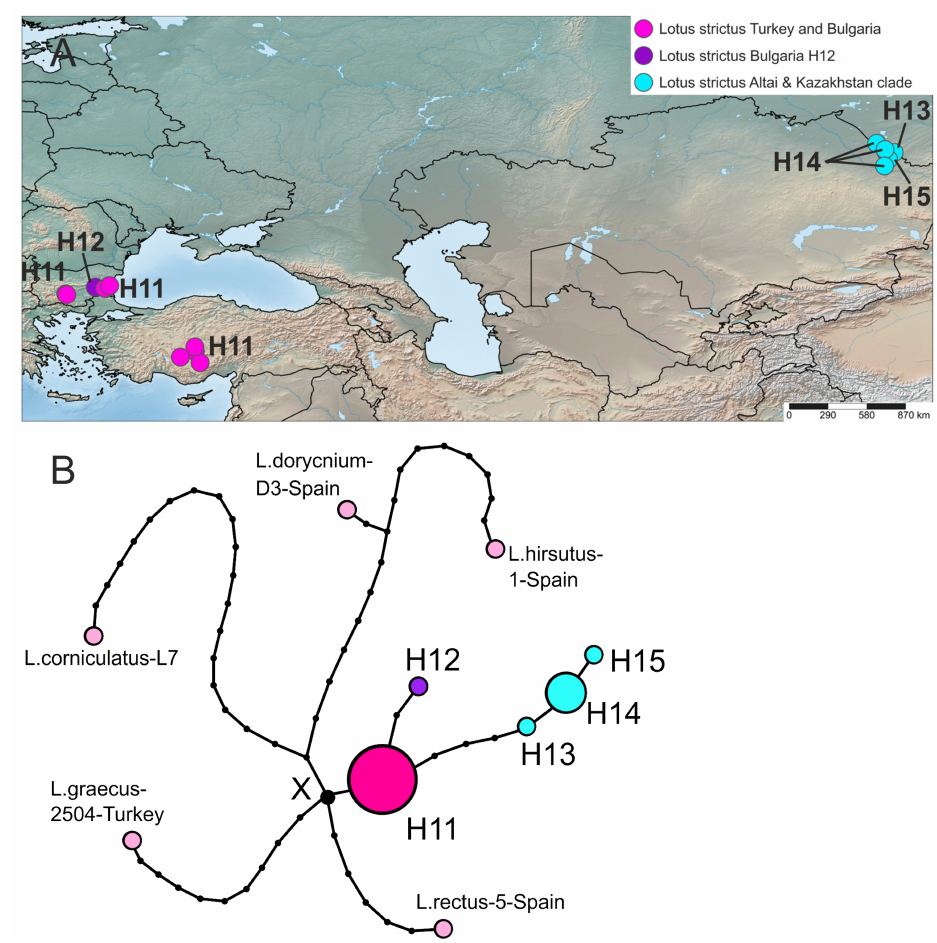
Figure 5. Geographical distribution of haplotypes identified in L. strictus ( A ) and haplotype network ( B ) reconstructed based on the combined plastid DNA dataset. The size of each circle is proportional to the frequency of the haplotype in the dataset. L. rectus , L. hirsutus , L. dorycnium , L. graecus , and L. corniculatus represent